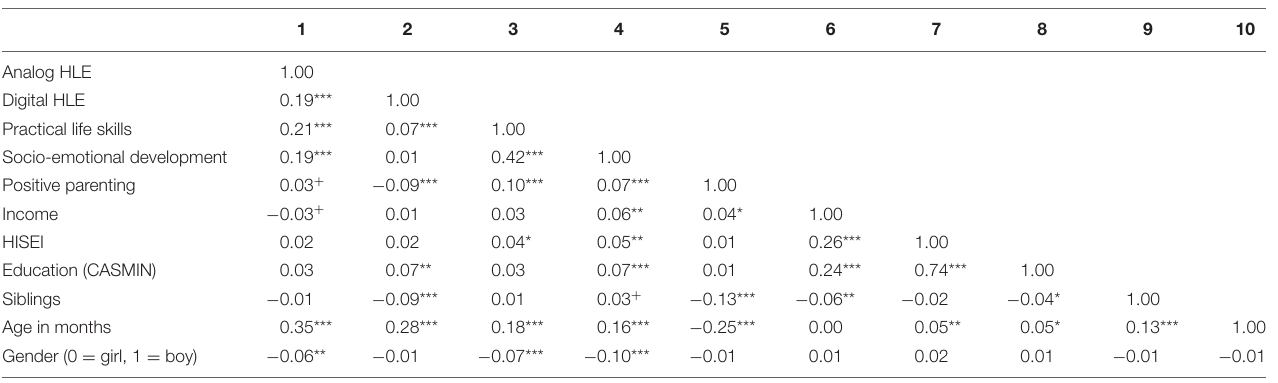
TABLE 3 | Bivariate correlations of the study variables in the toddler age group.